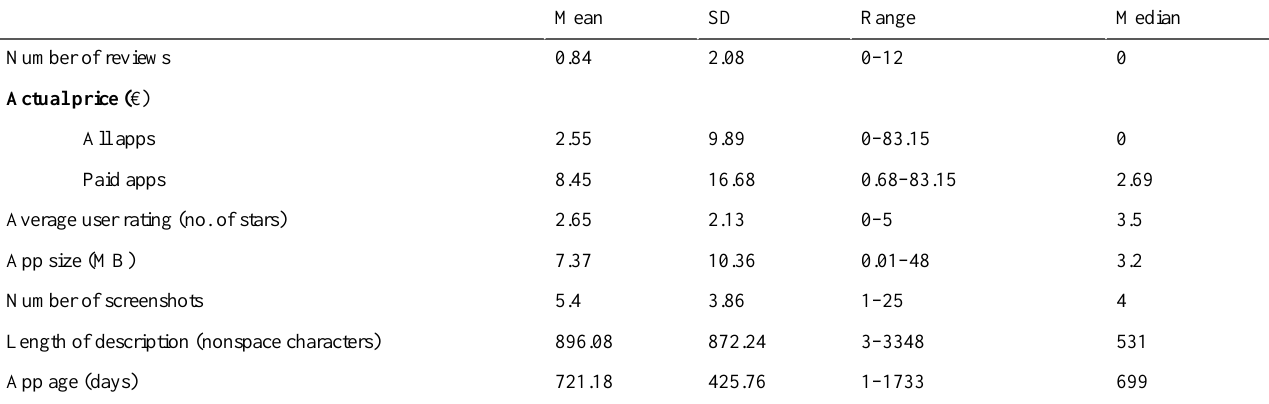
Table 2. Summary descriptive statistics for continuous variables for apps containing the term urology.